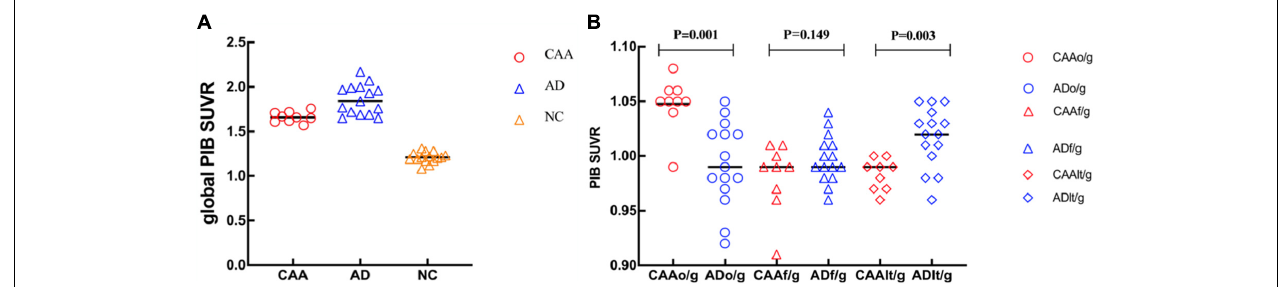
FIGURE 3 | Dot plots of global and regional PIB standardized uptake value ratio (SUVR) comparisons in patients with CAA and AD, and cognitively NC subjects. (A) Global SUVRs were significantly higher in CAA patients compared with NC subjects and significantly lower compared with AD patients. (B) CAA patients had